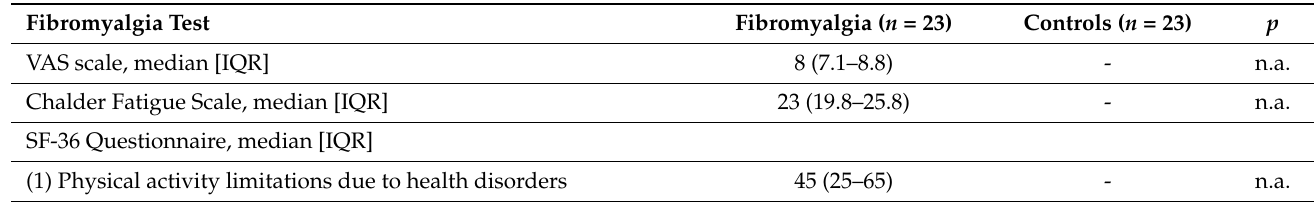
Table 3. Tests for fibromyalgia ( n =